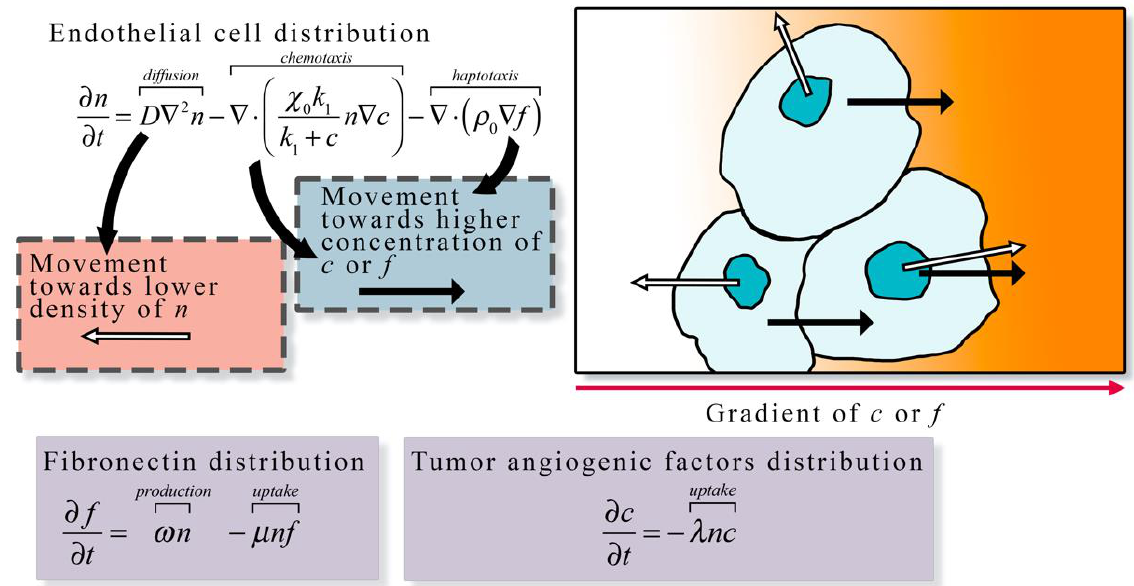
Figure 3. Continuum description of angiogenesis. The continuum description of angiogenesis developed by Anderson et al. [23] describes the spatial and temporal change in endothelial cell density ( n ) as the function of diffusion, chemotaxis along tumor angiogenic factor ( c ) gradients, and haptotaxis along fibronectin ( f ) gradients. Endothelial cell diffusion is characterized by a diffusion coefficient D , chemotaxis is characterized by chemotaxis coefficients χ 0 and k 1 , and haptotaxis is characterized by the haptotaxis coefficient ρ 0 . In the presence of other cells endothelial cell movement via diffusion is directed away from high densities of n (white arrows in the illustration), otherwise the movement via diffusion is random. Both chemotaxis and haptotaxis result in endothelial cell movement towards higher concentration of c or f (black arrows in the illustration), respectively. The change in fibronectin distribution over time is the function of the production at rate ω by endothelial cells and the uptake at rate µ by endothelial cells. The change in tumor angiogenic factor distribution is described by the uptake at rate λ by endothelial cells. The general formulation of the left-hand side of the equation expressing the rate of change of a quantity of interest, and the right-hand side describing all the ways it can change is frequently the over-arching guide for constructing such